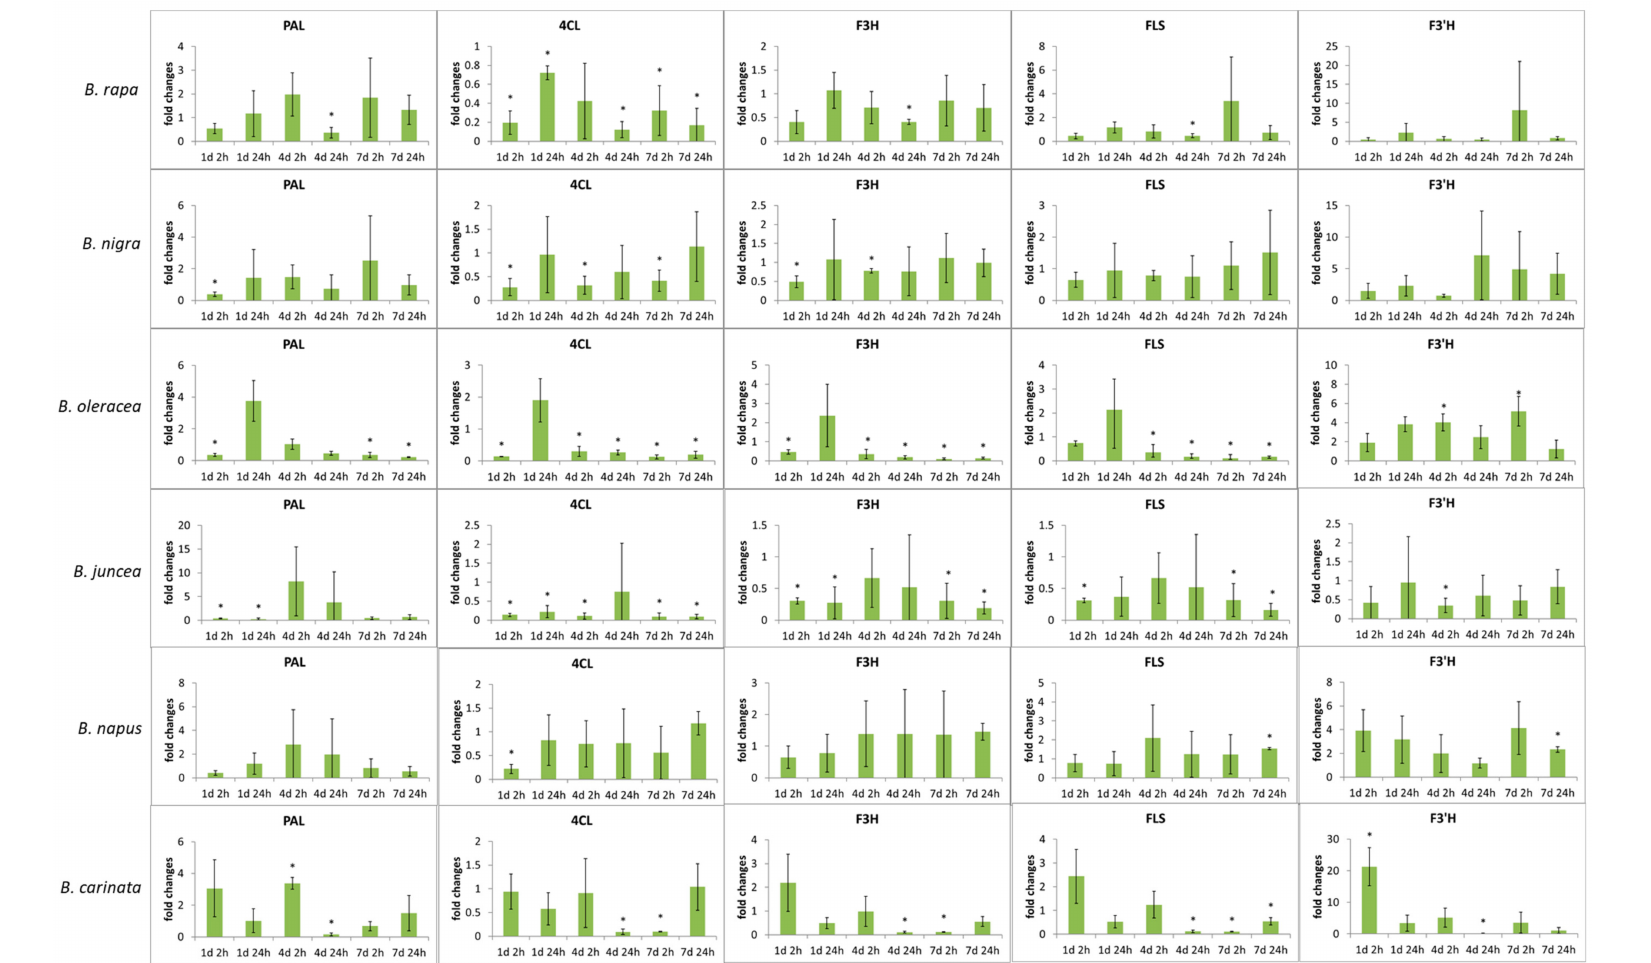
Figure 4. Relative expression of genes presumably coding for phenylalanine ammonia-lyase ( PAL ), 4-Coumaroyl CoA-Ligase ( 4CL ), flavanone 3 β -hydroxylase ( F3H ), flavonol synthase (FLS ), flavonol 3 (cid:48) -hydroxylase ( F3 (cid:48) H ) normalized on the basis of expression of actin at the certain time points (at days 1, 4, and 7 of the treatment with 2 h or 24 h of adaptation time after the last UV treatment). Significant differences are highlighted by an asterix at p ≤